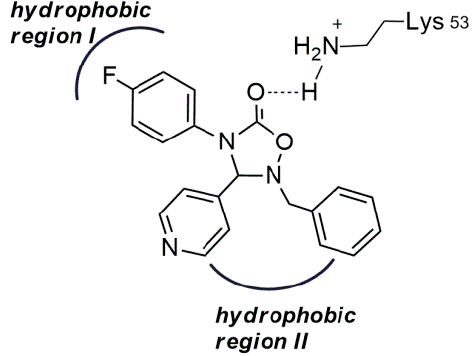
Figure 6. Possible binding mode of 3e to the ATP site of p38 α .